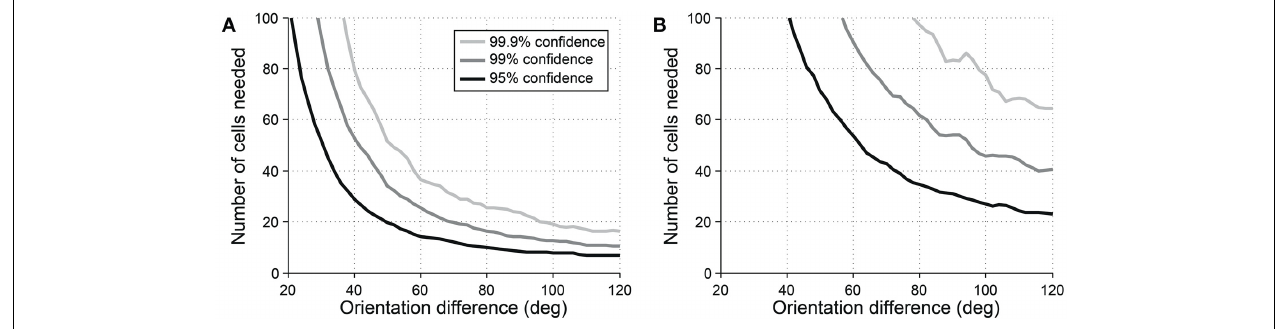
We measured the sensitivity for detecting the difference at three levels of confidence: 95, 99, and 99.9%. (A) Simulations performed using single-trial noise of 40% in all conditions. (B) Simulations performed using “2-photon OGB-1AM noise”: noise = 20 % + (10% × expected